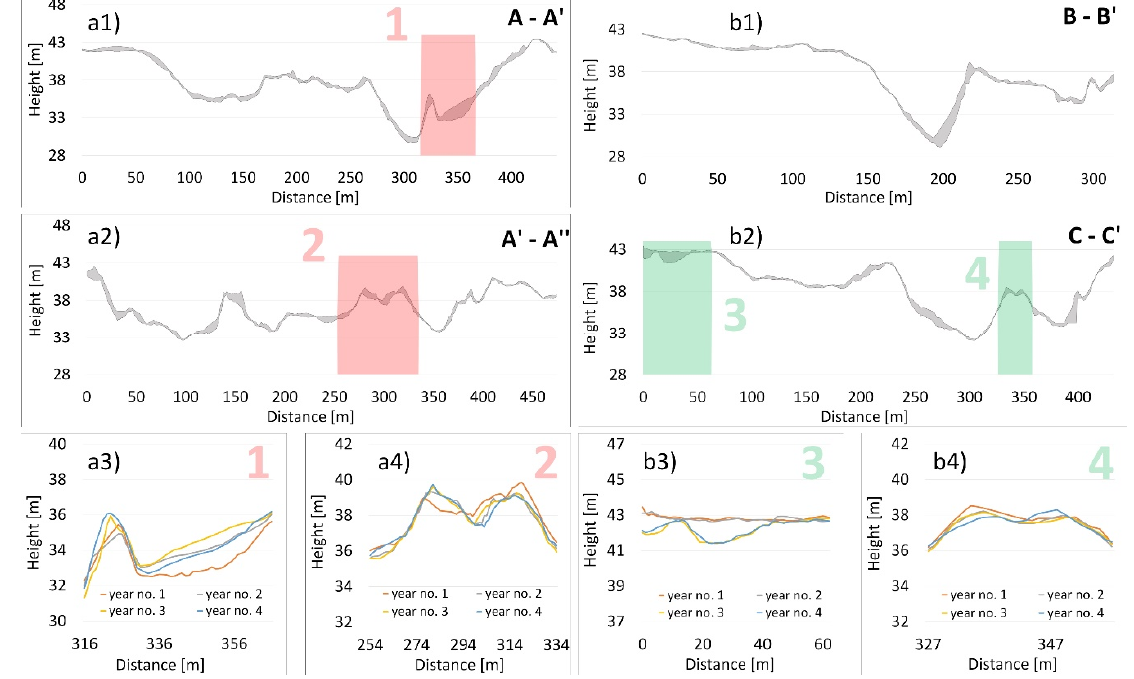
Figure 6. Changes in the river bed in ( a1 ) cross ‐ section A ‐ A ′ , ( a2 ) cross ‐ section A ′‐ A ′′ , ( a3 ) detail No. 1, ( a4 ) detail No. 2, ( b1 ) cross ‐ section B ‐ B ′ , ( b2 ) cross ‐ section C ‐ C ′ , ( b3 ) detail No. 3, ( b4 ) detail No. 4. 1, ( a4 ) detail No. 2, ( b1 ) cross-section B-B (cid:48) , ( b2 ) cross-section C-C (cid:48) , ( b3 ) detail No. 3, ( b4 ) detail No.